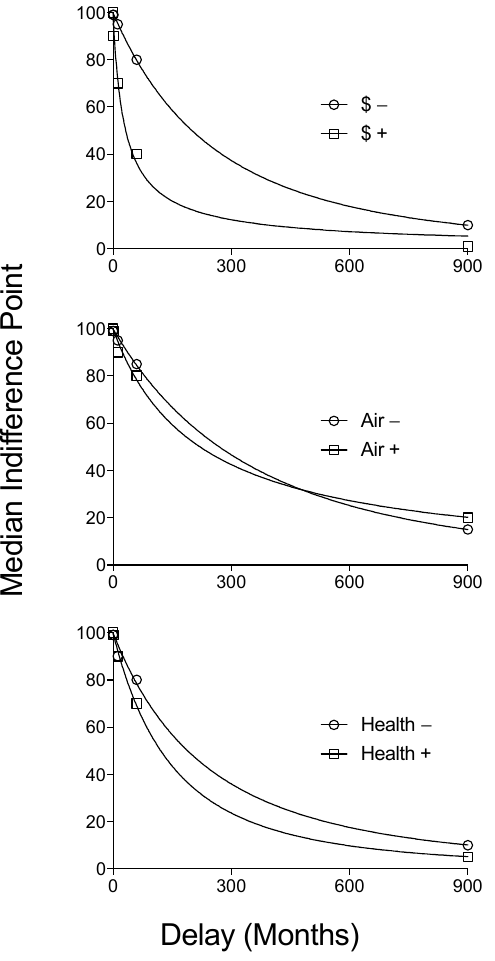
Figure 1. Median indifference points displayed as a function of delay for gains (squares) and losses (circles) across monetary (top panel) air quality (middle panel), and respiratory heath (bottom panel) outcomes.